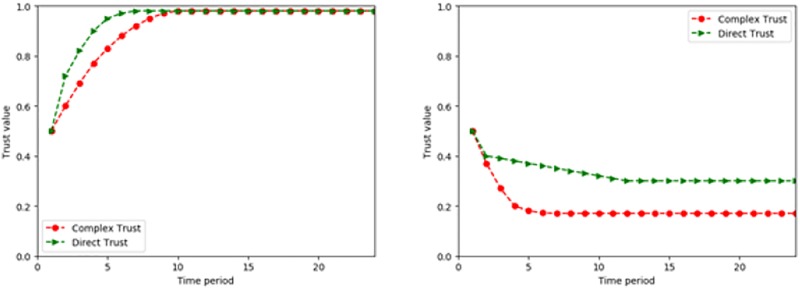
Trust values of nodes in different evaluation methods.(a) Normal node evaluation factor impact. (b) Untrust node evaluation factor impact.